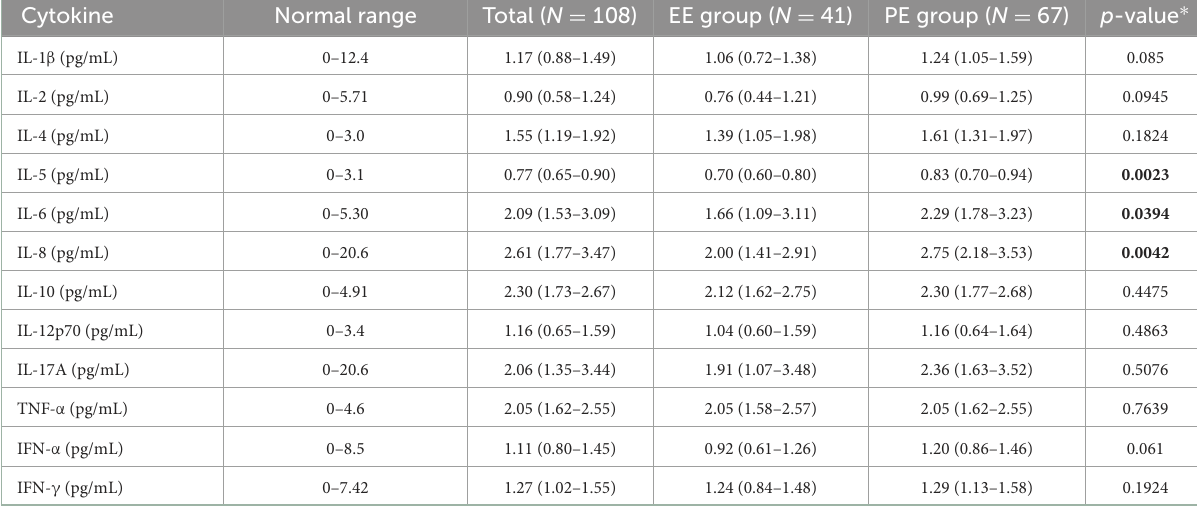
TABLE 2 Serum cytokine expression in COVID-19 patients.